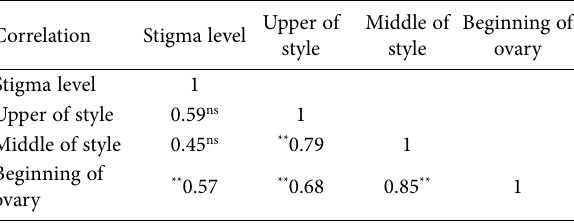
Table 2. Pearson correlation coefficients for the effect of the Zn on the pollen germination percentage on the stigma and pollen tube penetration to the upper and middle parts of the style and so the beginning of the